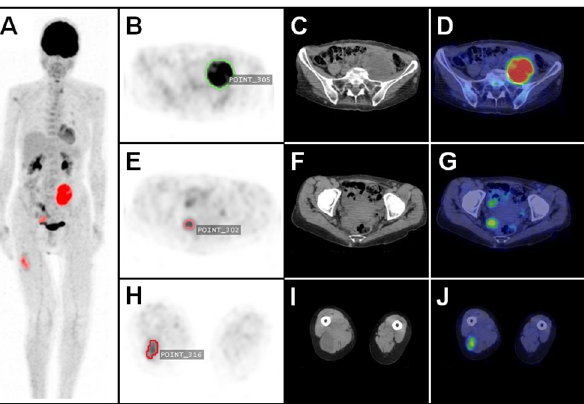
Fig 1. Automated 3D-segmentation and volumetric assessment of nerve sheath tumors. Maximum intensity projection PET image ( A ) with automatically delineated metabolically active tumors ( red ). Axial PET image ( B ) with volumetric ROI ( green ) of a MPNST (SUV max / MTV / TLG: 11.2 / 182592 / 894700) in the left pelvis; corresponding CT ( C ) and fused PET/CT image (D). Axial PET image ( E ) with volumetric ROI ( light red ) of a plexiform neurofibroma (PNF) (SUV max / MTV / TLG: 4.7 / 14848 / 41574) close to the rectum; corresponding CT ( F ) and PET/CT image ( G ). Axial PET image (H) with volumetric ROI ( dark red ) of a BPNST (SUV max / MTV / TLG: 3.7 / 15872 / 41267) in the right thigh; corresponding CT ( I ) and PET/CT image ( J ).